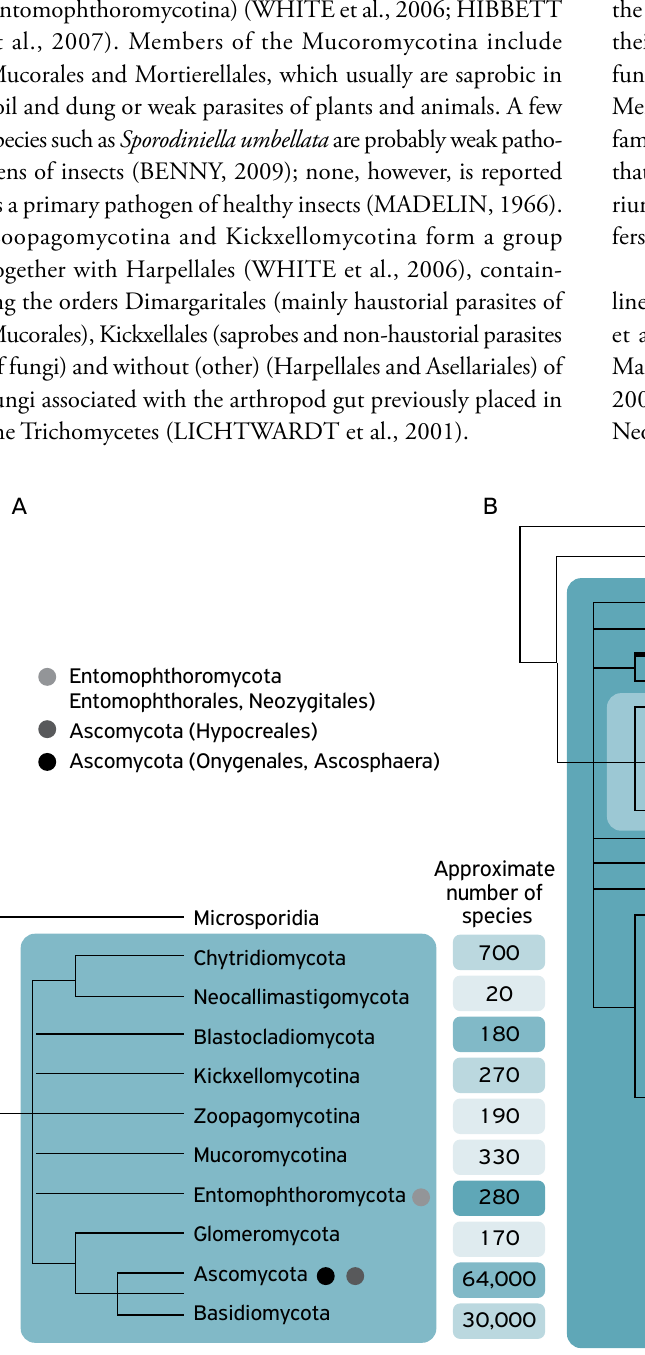
Figure 1. Phylogenetic positions of insect pathogenic fungi. (A) The Kingdom Fungi, with emphasis on phyla with insect pathogens. The numbers represent the approximate number of species described within each (sub)phylum and the shading in ten units in the boxes represents the relative proportions of known species of insect pathogens (highest proportion when blue color is darker). Light grey, black and dark grey dots mark the branches with the most common and best-known insect pathogens. (B) Ascomycota have the highest number of described species and the greatest diversity, including a variety of saprophytic, mutualistic and pathogenic life forms. The thick lines represent orders with insect pathogenic fungi and light grey, black and dark grey dots mark those with the most known insect pathogens: Hypocreales (dark grey, for example, Cordyceps sensulato , Metarhizium and Beauveria ) and Onygenales (black, Ascosphaera ) (HIBBETT et al., 2007; JAMES et al., 2006; WHITE et al.,